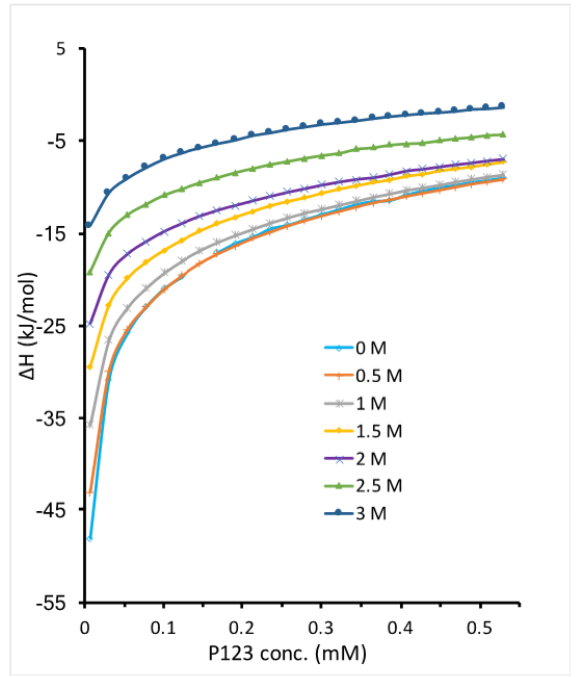
Figure 7. The enthalpy change of titrating 3.2 mM Pluronic P123 in EAN aqueous solution into EAN aqueous solution with the same content at 30 °C. The EAN concentration in each experiment is shown in the legend.